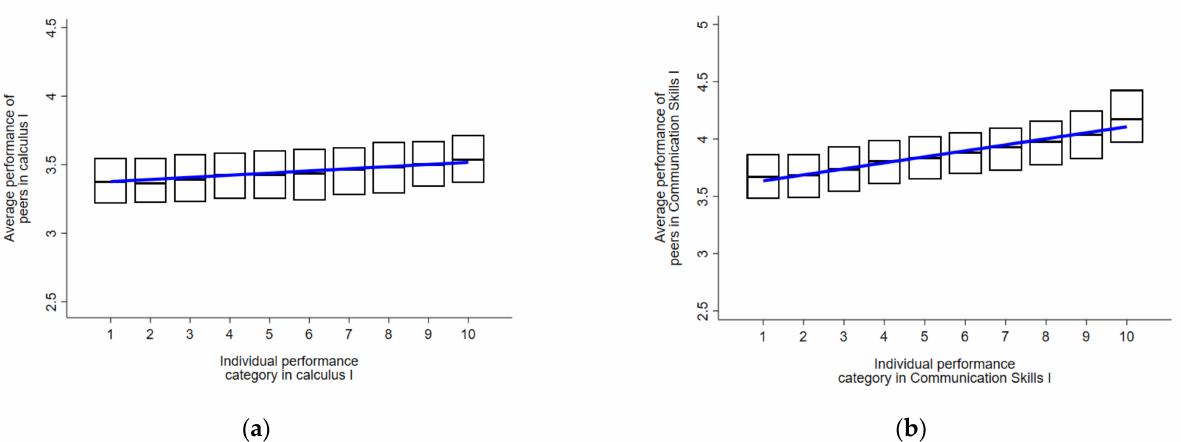
Figure 2. Peer performance distribution by student performance category: ( a ) Calculus I; ( b ) Communication Skills I. Source: Authors’ preparation.